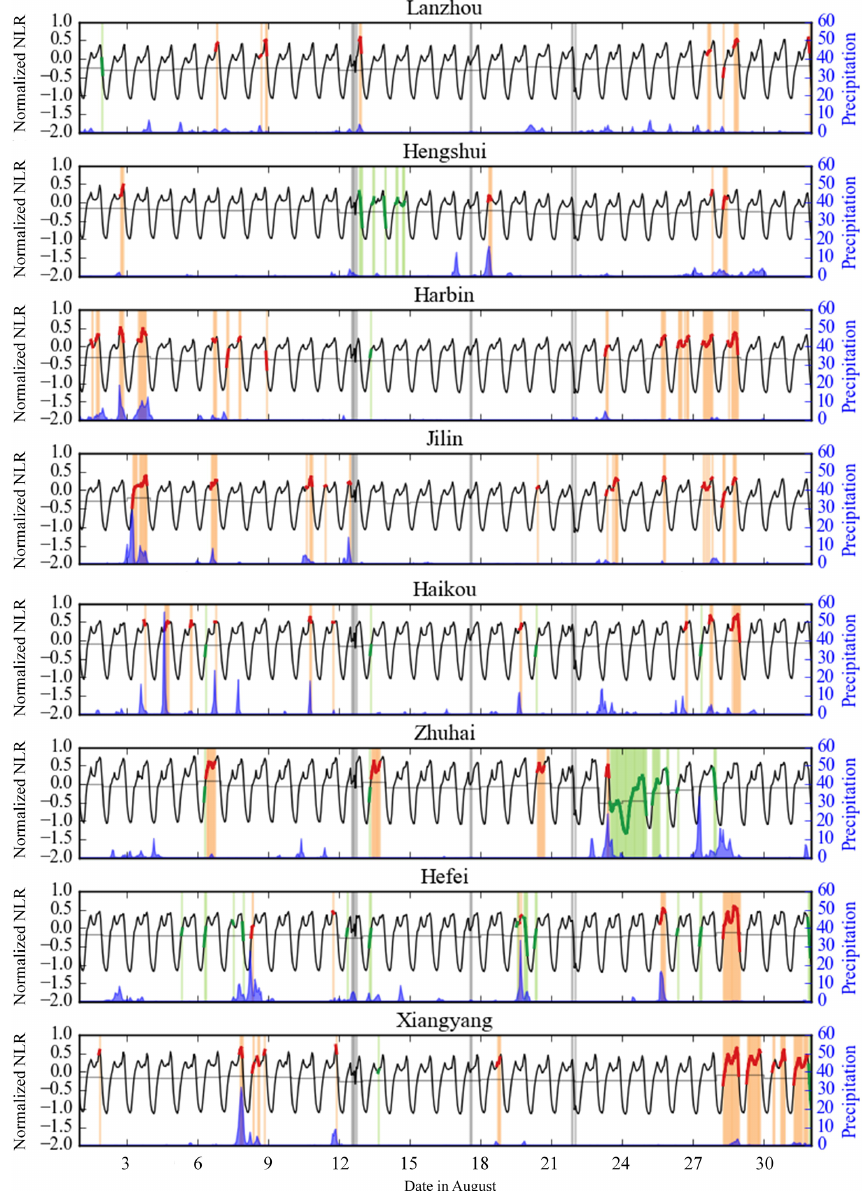
Figure 4. The time series NLR and rain events during August 2017. Positive and negative anomalies are shown in orange and green, respectively. The light gray columns show the periods when NLR data are